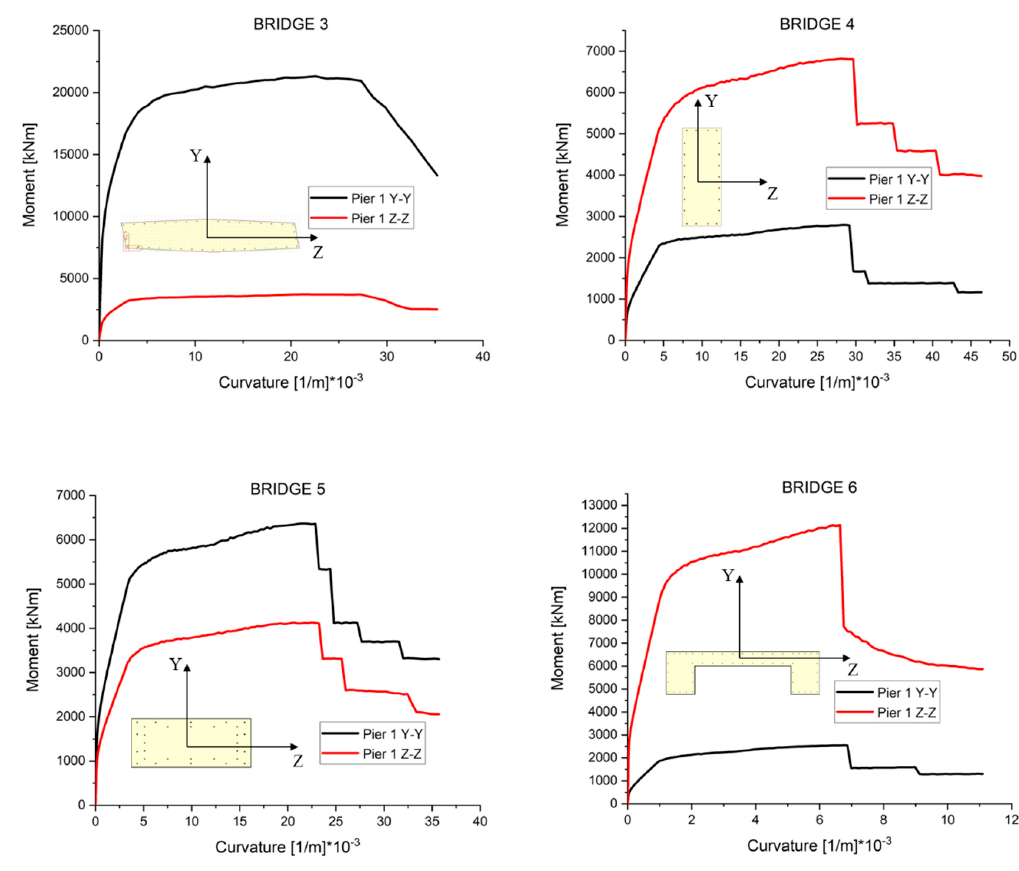
Figure 11. Moment-curvature diagrams of different bridges’ piers.